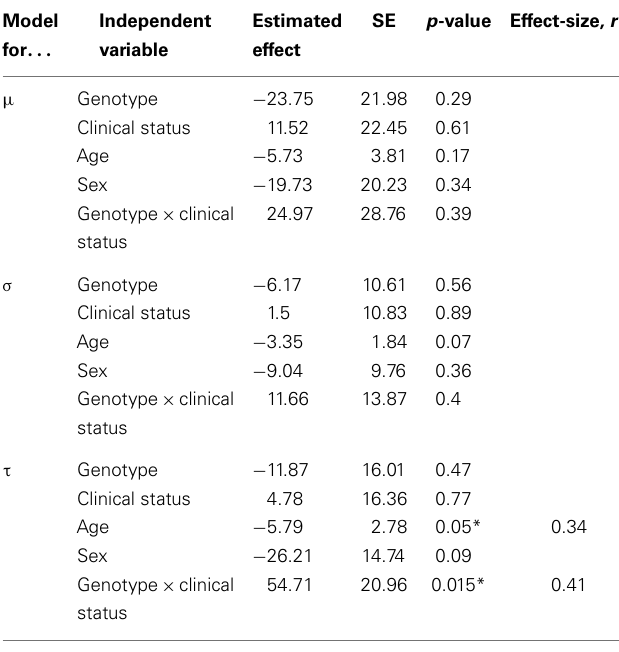
FIGURE 3 | Differential effect of DRD4 genotype on τ (tau) among ADHD children versus their asymptomatic siblings .